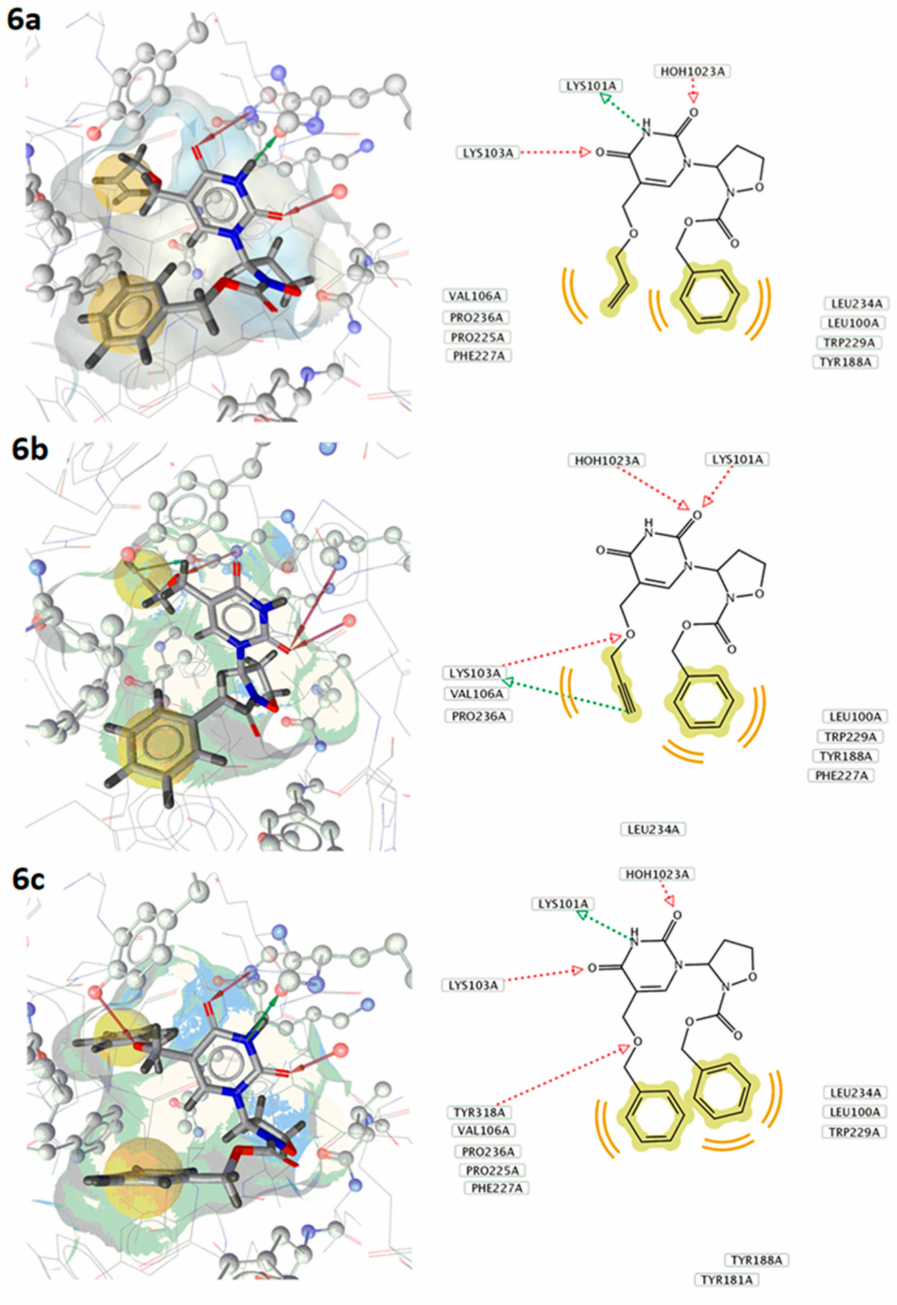
Figure 3. Docking interactions for compounds 6a , 6b and 6c